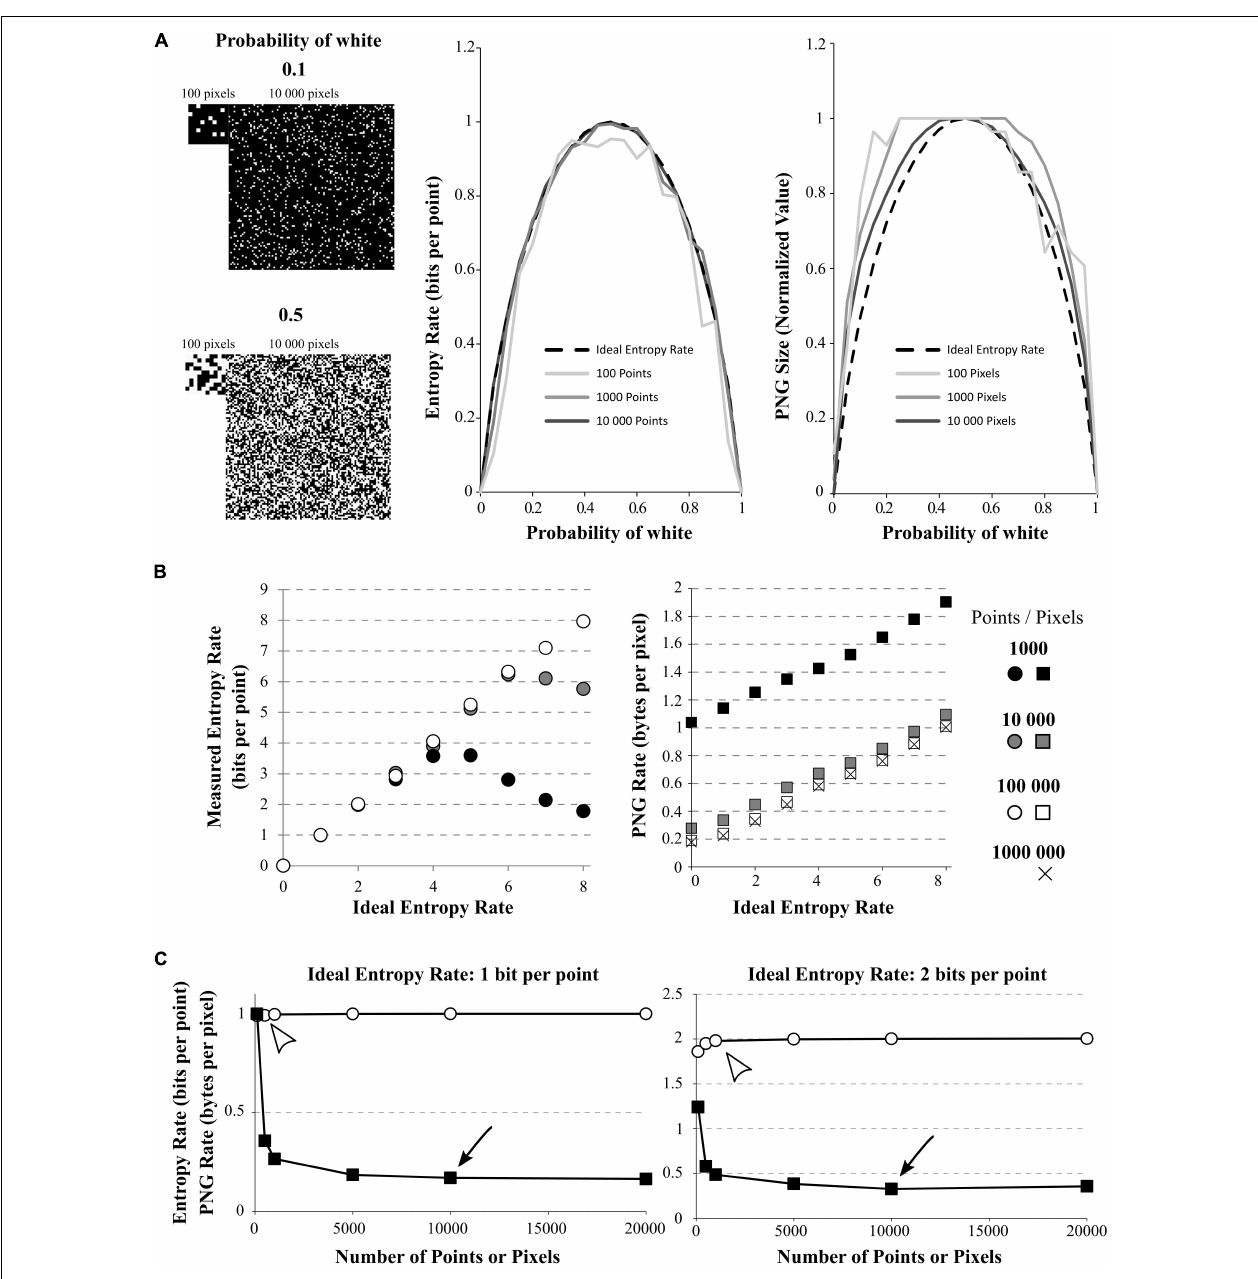
FIGURE 2 | Effect of signal size on quadratic extrapolations method and PNG Rate. (A) Left: The signals have 2 possible values (1 or 0, here shown by black or white) and can be of length 100, 1,000, or 10,000 data points (only 100 and 10,000 points signals are shown). The signals with growing amount of white points (from 0 to 100%). Here, example of 10% of white points (up) or 50% of white points (down) are shown. Middle: In dashed line: the ideal bell-shaped curve calculated by the Shannon’s formula. When using the quadratic extrapolations method, we needed at least 10,000 points to converge to the ideal bell-shaped curve (compare dark gray line to black dashed line). However, if our signal is short, it is impossible to calculate high entropy values (100 points for example, light gray curve). Right: normalized PNG file sizes of the same signals, showing that when we increase the number of points in the signal, we progressively fit the obtained curve toward the ideal entropy curve. This convergence is slower than when using the quadratic extrapolations method. (B) Effect of the number of points on entropy calculation for white-noise signals. The different signals differ by their number of possible values (from 1 to 256 possible values leading to ideal entropy rates from 0 bits/point to 8 bits/point) and by their number of points (from 1,000 to 1,000,000 points). Left: Effect of the number of points on the entropy rate calculation via the quadratic extrapolations method (QEM). For signal with few points (1,000 and 10,000 points), the curve shows a biphasic behavior revealing the sampling disaster: a signal of few points cannot be used to calculate high entropy values. When increasing the number of points, the curve becomes accurate for every entropy value. Right: same demonstration when using the PNG Rates. Even with few points, the curve shows a linear behavior. However, increasing the number of points modifies the slope and intercept of the linear curve, until it stabilizes to an optimal solution. (C) Effect of the number of points on entropy calculation for white-noise signals. The different